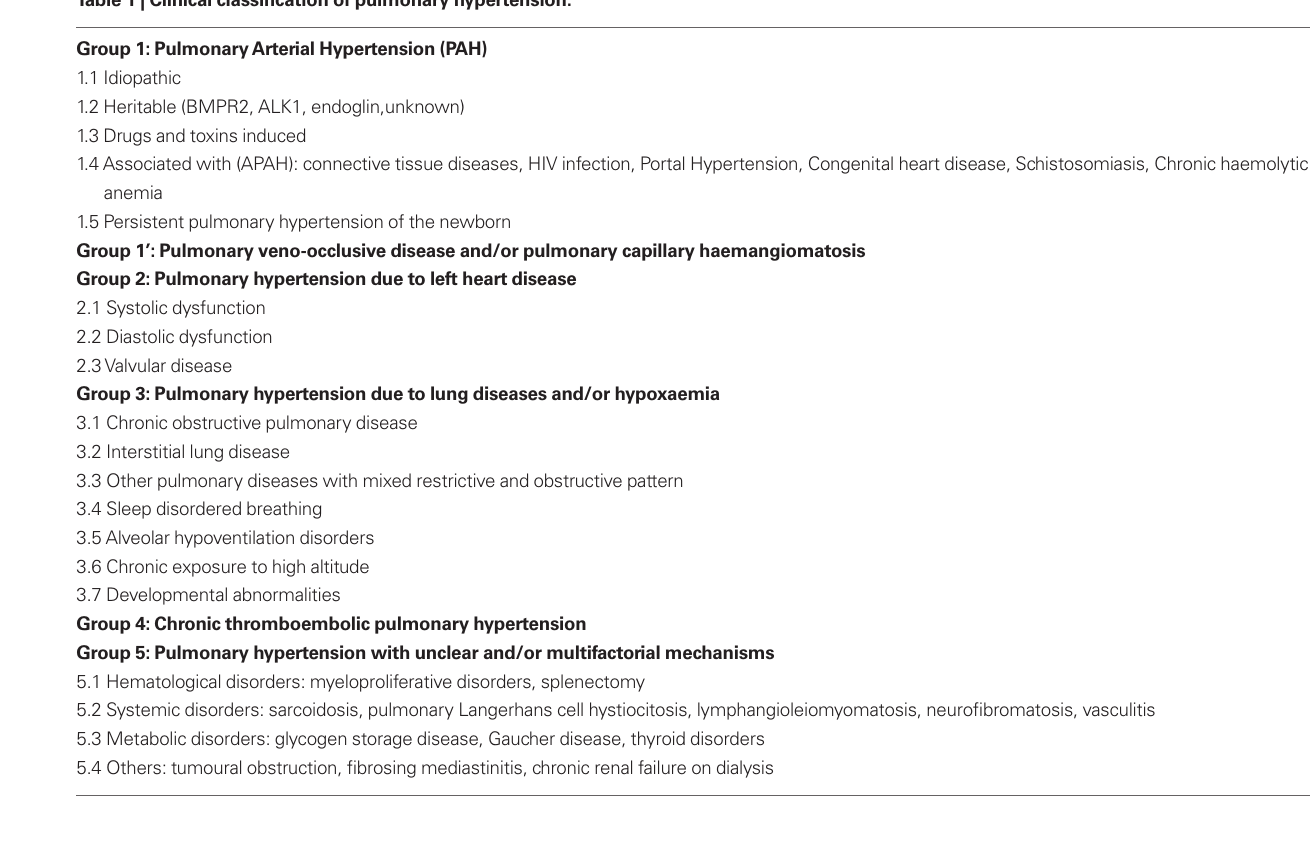
Table 2 | Functional classification of pulmonary hypertension according to World Health Organization